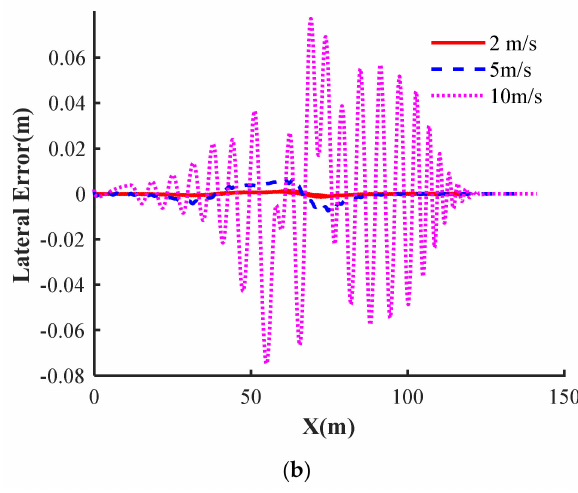
Figure 9. Tracking comparison at a different speed. ( a ) Trajectory tracking; ( b ) Lateral error.